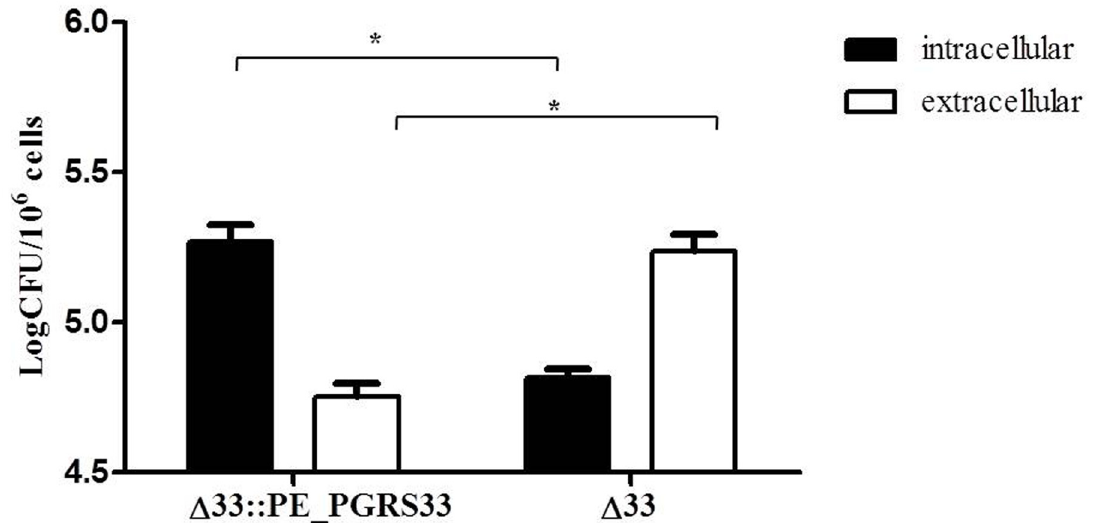
Fig 2. Deletion of PE_PGRS33 gene is associated with a defect in bacterial entry in pMM0 . pMM0 were infected with Mtb H37Rv, Mtb Δ 33 and Mtb Δ 33::PE_PGRS33 strains at MOI 1:1 to measure the number of intracellular vs extracellular bacteria at 4h post infection. Results of one representative experiments from at least three assays are shown ( * p < 0.05). CFUs were expressed as mean ± SD and were analysed by two-way ANOVA followed by Bonferroni posttest.